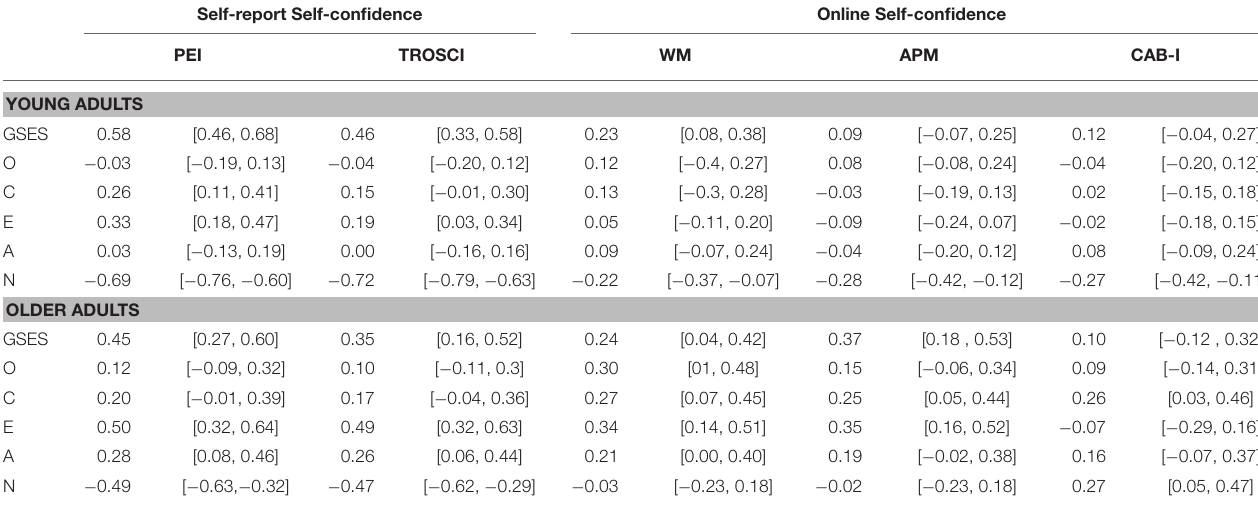
TABLE 4 | Correlations and 95% confidence intervals for self-efficacy (GSES) and personality (OCEAN) with both self-report and online measures of self-confidence for young ( n = 144) and older adults ( n = 91). Self-report Self-confidence Online